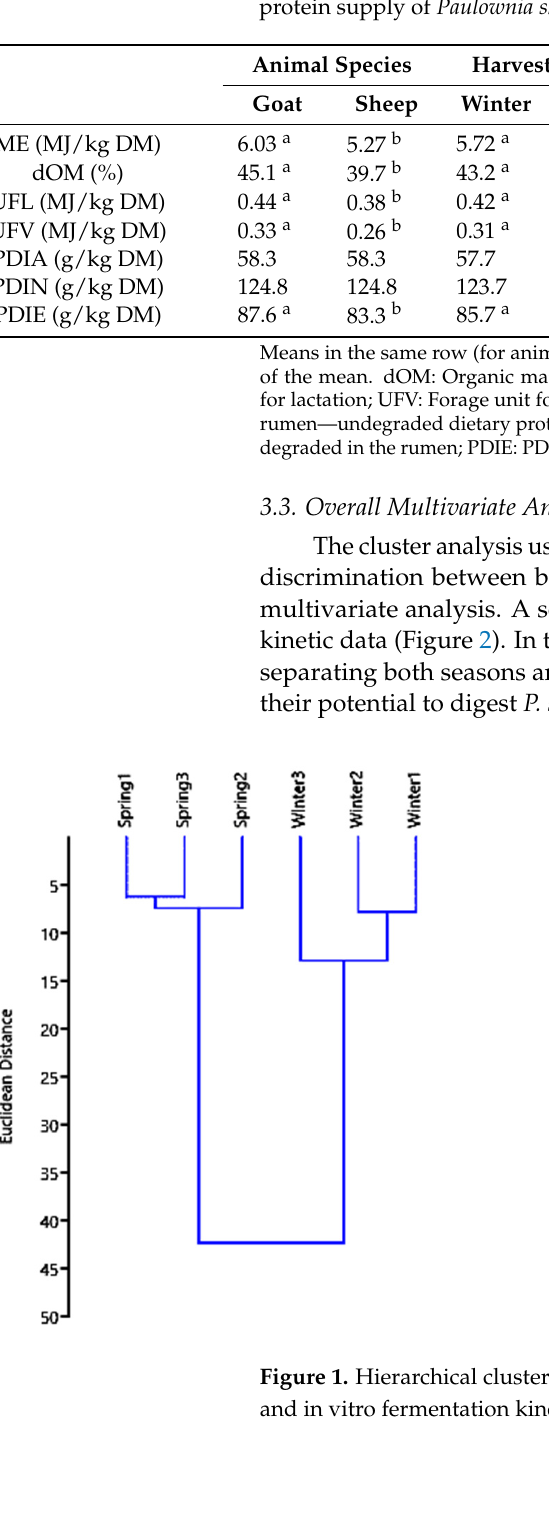
Figure 2. Hierarchical clustering of harvest seasons of Paulownia shan tong using in vitro fermenta- tion kinetic data using sheep or goat ruminal inocula (SS = sheep—spring; SW = sheep—winter; GS = goat—spring; GW = goat—winter). 4. Discussion 4.1. Chemical Composition and Secondary Metabolites The leaves of many trees contain high concentrations of basic nutrients and bioactive substances, making them recognized sources of feed for ruminants year-round [3,31]. One of these trees is Paulownia , planted mainly for wood production and producing about 54 tons of by-product per hectare [8]. In Tunisia, planting Paulownia is encouraged by the government, especially in areas affected by erosion and poor soil as well as in industrial zones. Paulownia is considered able to improve the soil and control the pollution of subsoil waters that have high levels of heavy metals, chemicals, and animal-waste pollutants. In addition to controlling erosion, Paulownia serves as a shelter and barrier from the sun and winds, purifies the air from pollutants, and releases large quantities of O 2 . It also has the capacity to absorb CO 2 ten times more than other tree species and contributes to the en- richment of the landscape and the biological diversity of the country. It can also be culti- vated with other plant species (intercropping). In our present study, P. shong tong was studied to evaluate its nutritional value for small ruminant species based on its chemical